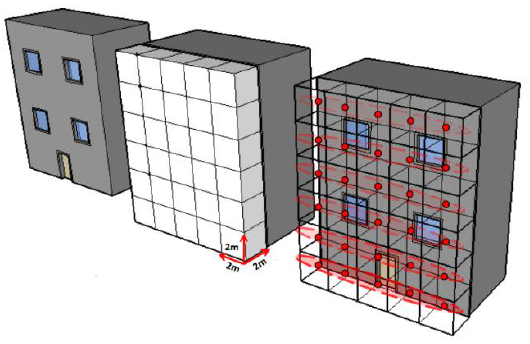
Figure 5. Integrating simulation data into GIS database